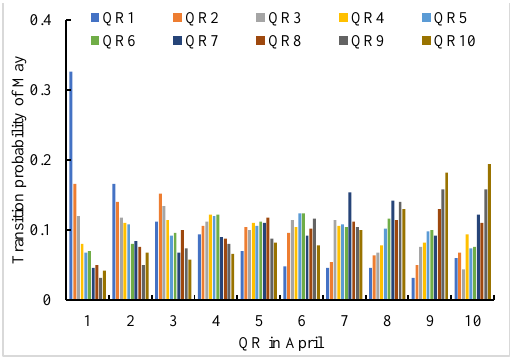
Figure 10. Transfer probability of the NZD hydropower plant for simulated runoff.